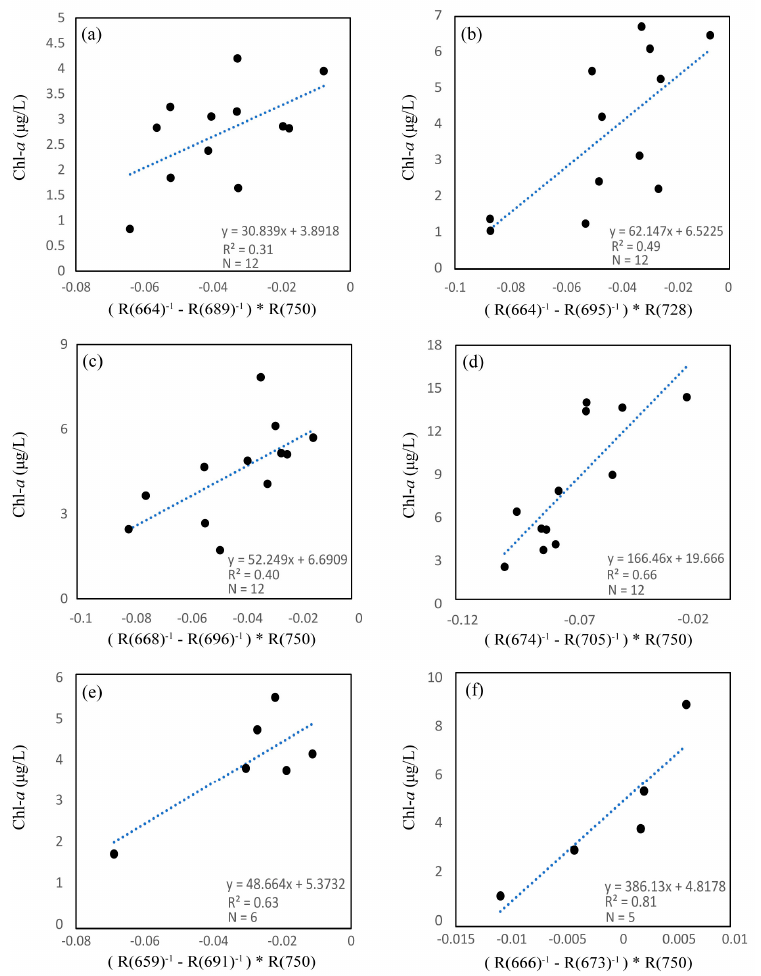
Figure 9. Calibrations between the three-band model algorithm and chlorophyll a (Chl-a) concentrations (( a – f ) are stations 1 to 6 in